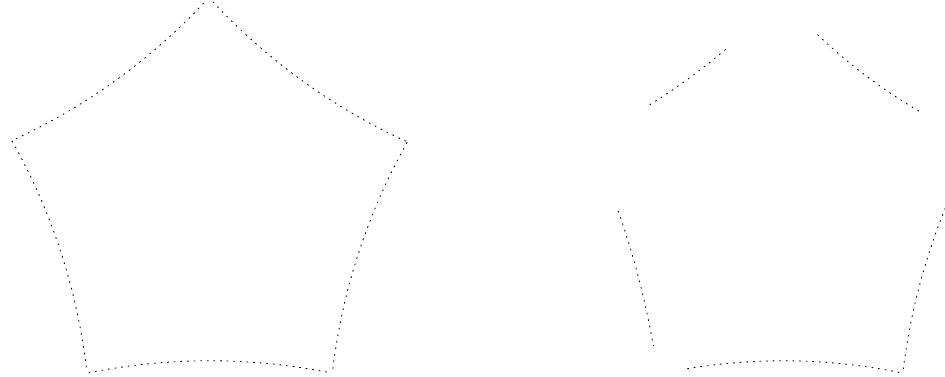
Figure 2. Illustration for k = 5; the figure is not to scale. Left: the point set resembles a slightly deflated pentagon. Right: after peeling off some of the